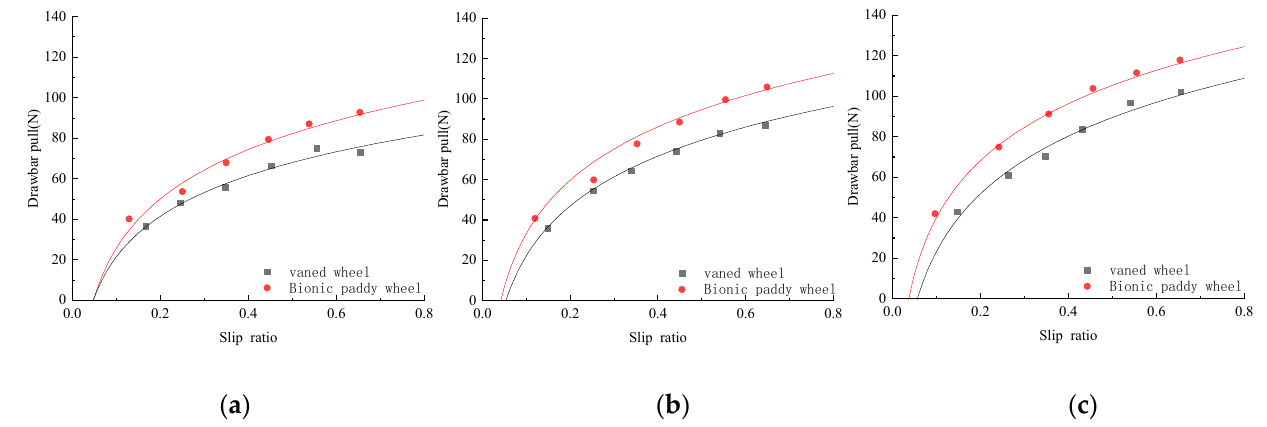
Figure 5. The comparison of drawbar pull and slip ratio of different wheels. ( a ) Wheel load 58.57 N, ( b ) wheel load 84.57 N, ( c ) wheel load 107.4 N.